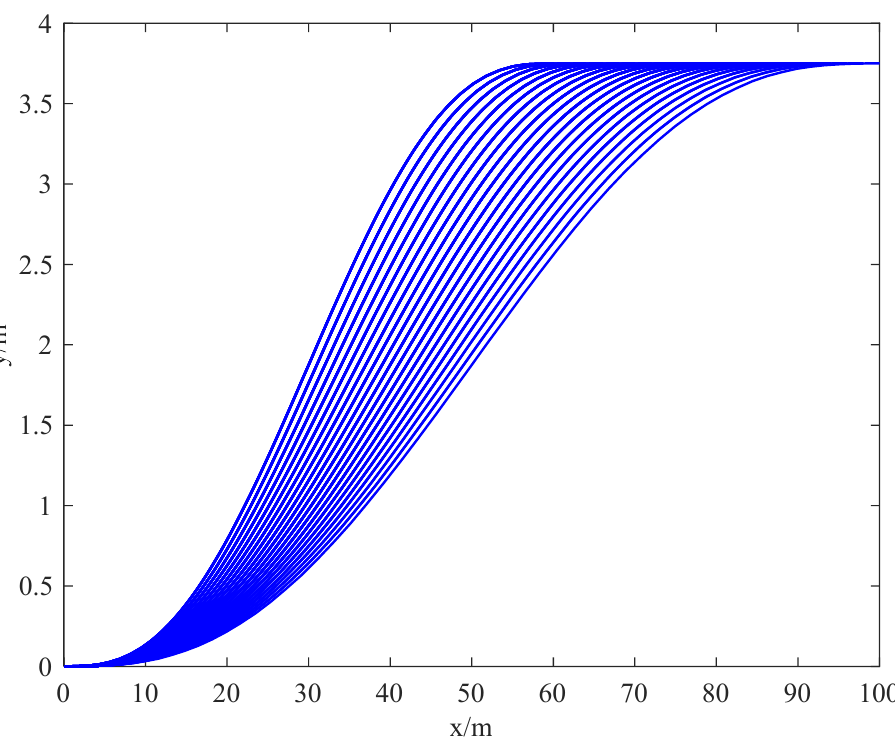
Figure 5. Feasible lane changing trajectory cluster.